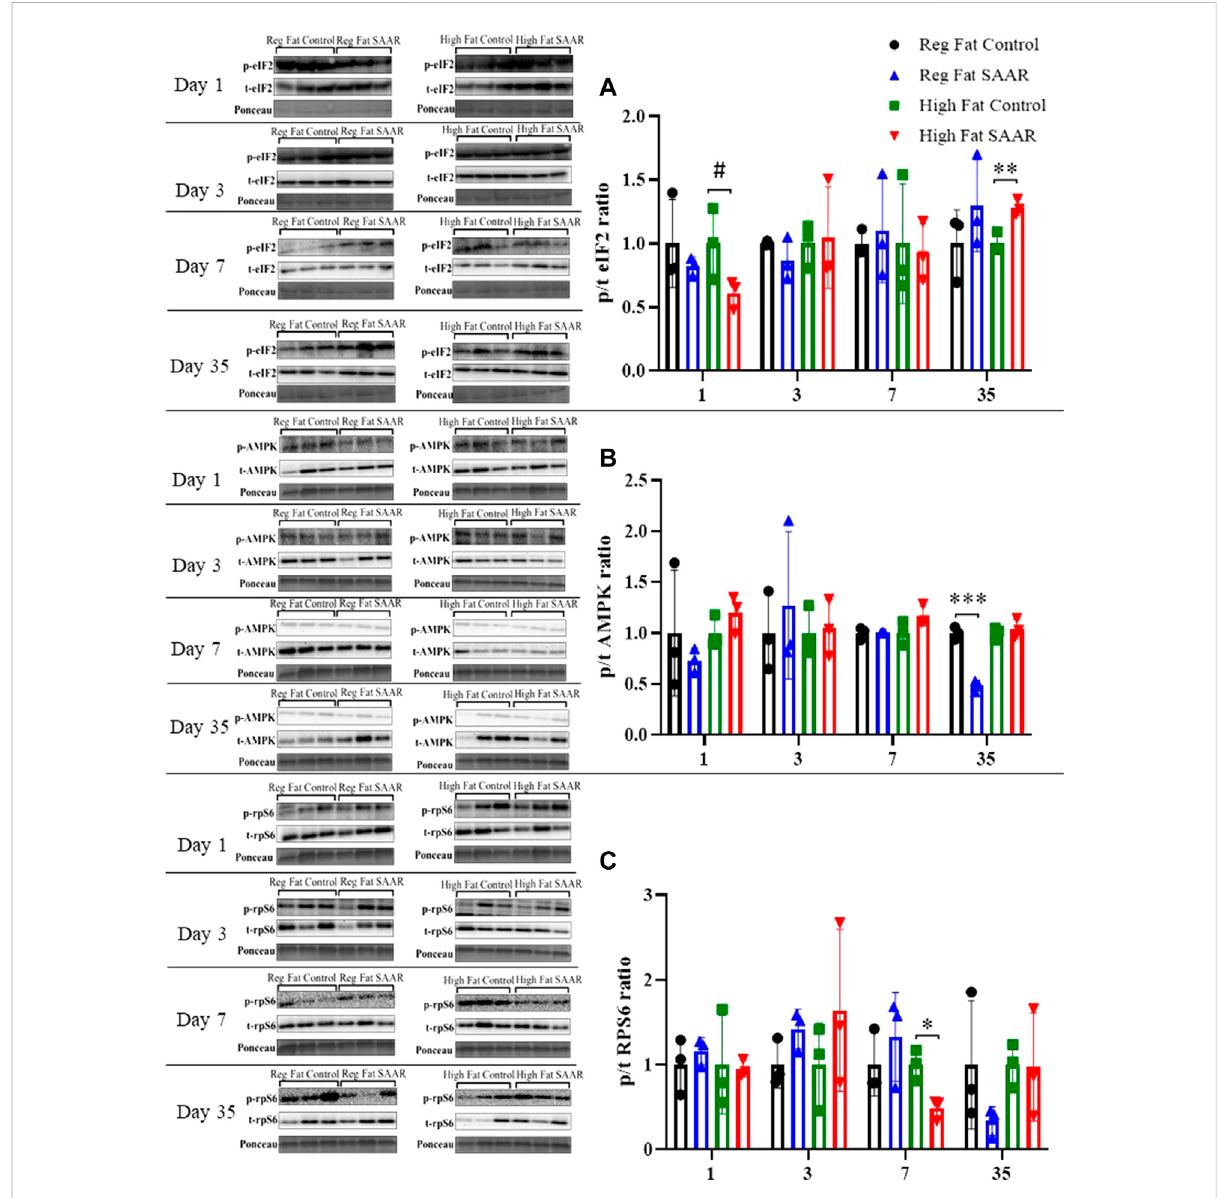
FIGURE 4 Immunoblot data for eIF2, AMPK, and rpS6 at days 1, 3, 7, and 35 in gastrocnemius homogenates. (A) At day 1, mice fed a High Fat SAAR diet tended to have lower eIF2 activation than control. By day 35, mice fed a High Fat SAAR diet had greater eIF2 activation. (B) AMPK activation was signi fi cantly lower in mice fed a Regular Fat SAAR diet at day 35. There were no signi fi cant differences at other timepoints for other groups. (C) rpS6 activation was signi fi cantly lower in mice fed a High Fat SAAR diet at day 7 compared to control, however, no signi fi cant differences were detected at other timepoints and diets. Data are presented as mean ± SD ( n = 3/group). eIF2, eukaryotic initiation factor 2; AMPK; AMP-activated protein kinase; rpS6, ribosomal protein S6. * p < 0.05, ** p < 0.01, *** p < 0.001, # 0.05 < p < 0.10. SAAR diets are compared to their respective methionine suf fi cient control